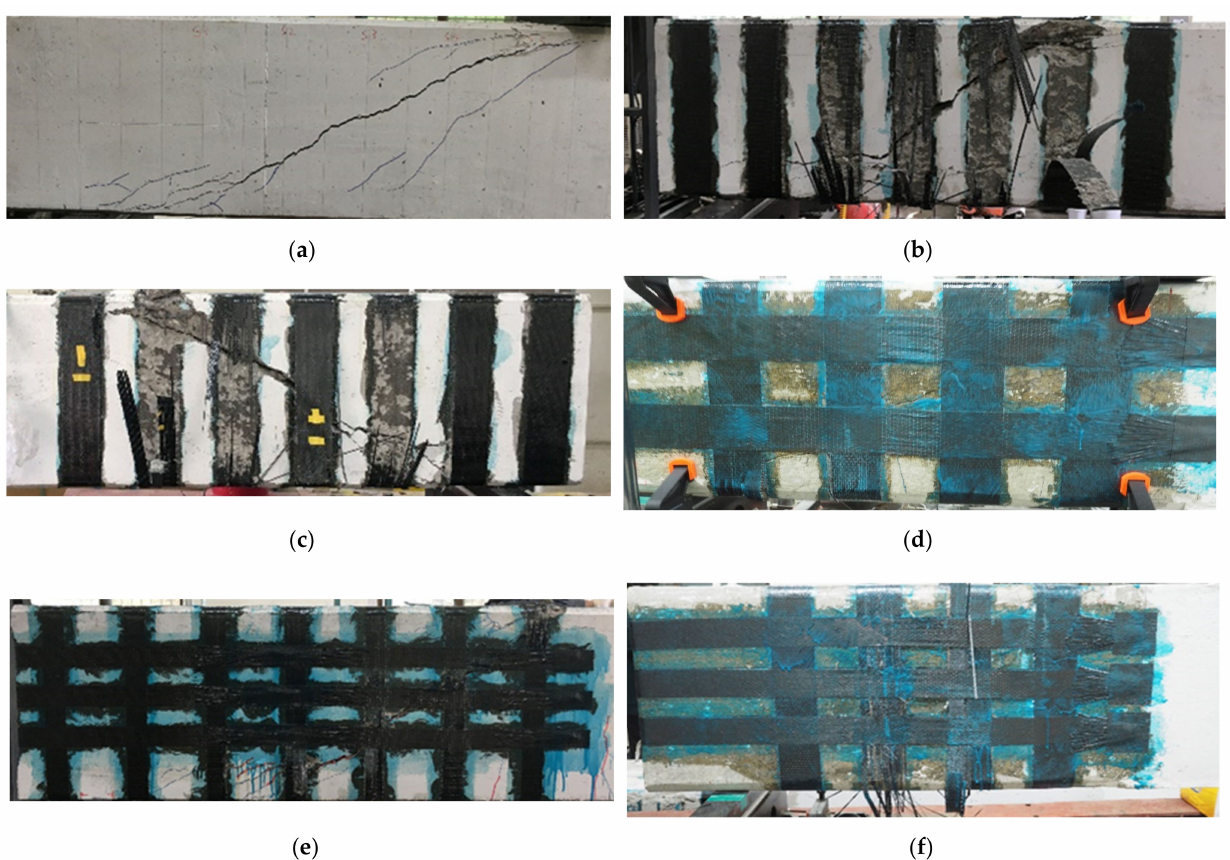
Figure 5. Cracking pattern and CFRP strip fracture in the representative specimens: ( a ) cracking and shear failure in control specimen (100-C-00); ( b ) CFRP fracture in fully-wrapped specimen with unidirectional layout (200-U-1F); ( c ) strip fracture in fully-wrapped repaired specimen with unidirectional layout (100-U-1F(R)); ( d ) CFRP fracture in side-bonded specimen with bidirectional layout (200-B-1S); ( e ) CFRP fracture in fully-wrapped repaired specimen with bidirectional layout (200-B-1F(R)); ( f ) CFRP fracture in fully-wrapped specimen with bidirectional layout